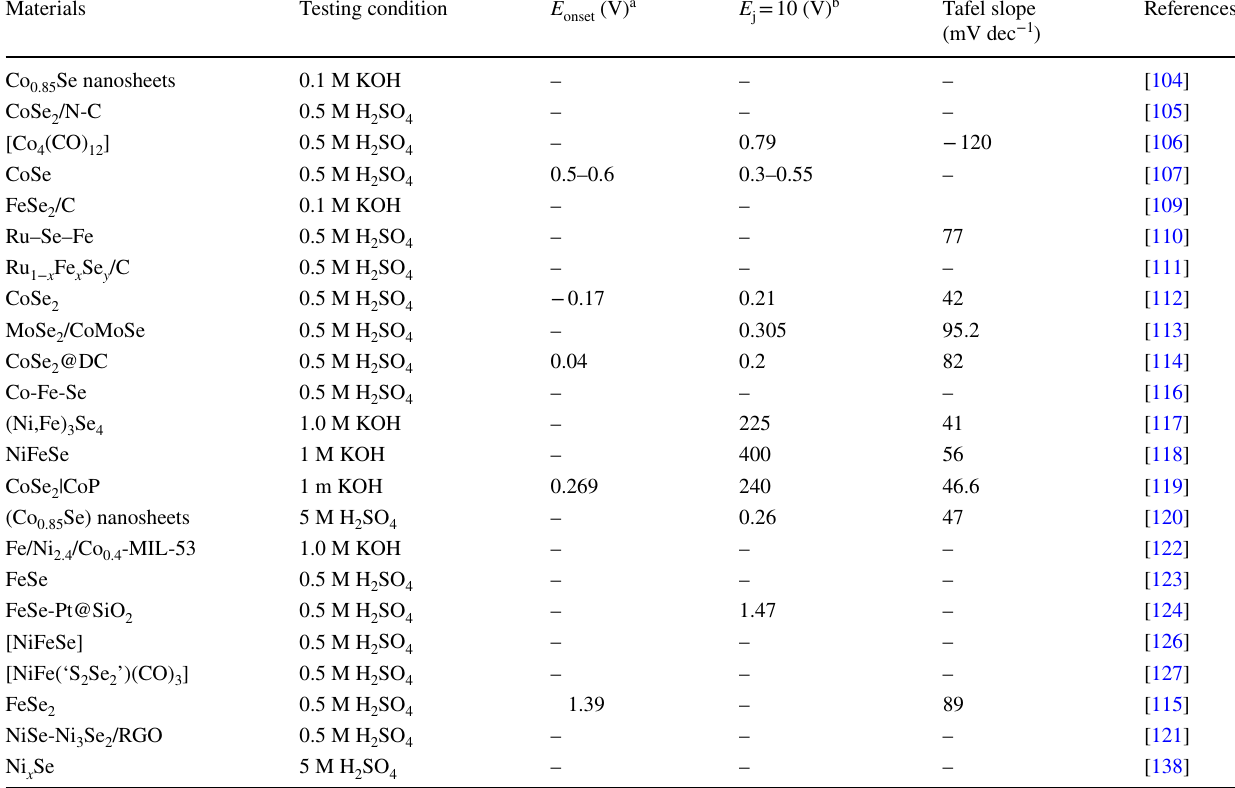
Table 3 Application of iron/cobalt/nickel selenium in electrocatalysis